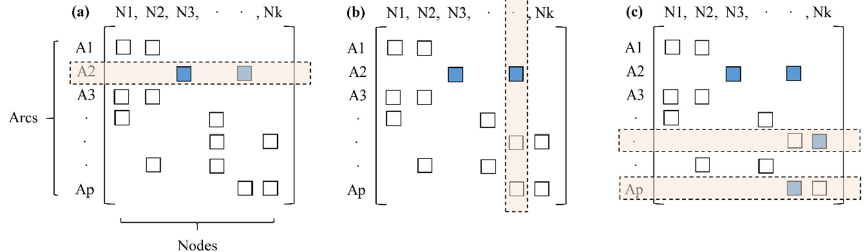
Figure 2. Network model representation for tracking the sources.